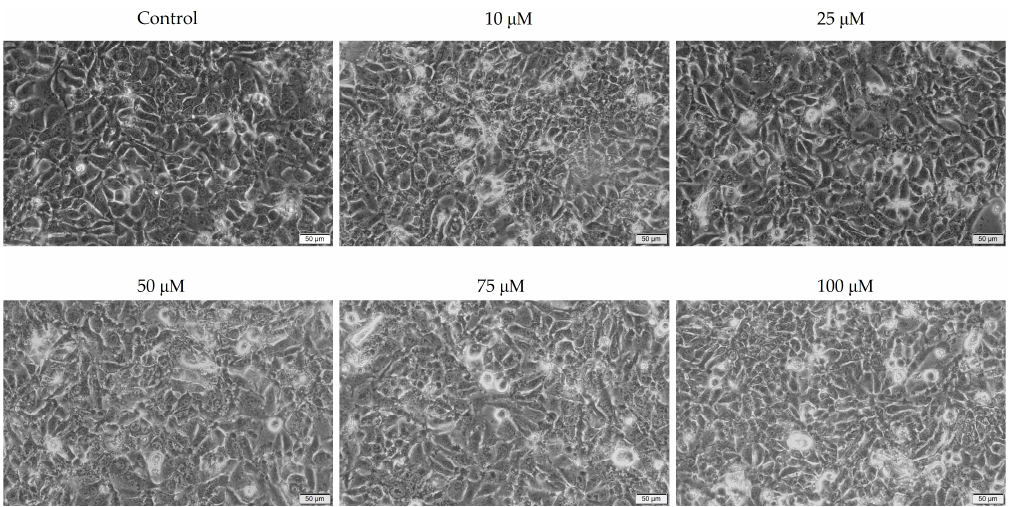
Figure 3. In vitro morphological changes of Detroit-562 cells after 72 h of stimulation with ampicillin (10, 25, 50, 75, and 100 µ M). The pictures were taken at a magnification of 20 × , and the scale bar indicates 50 µ